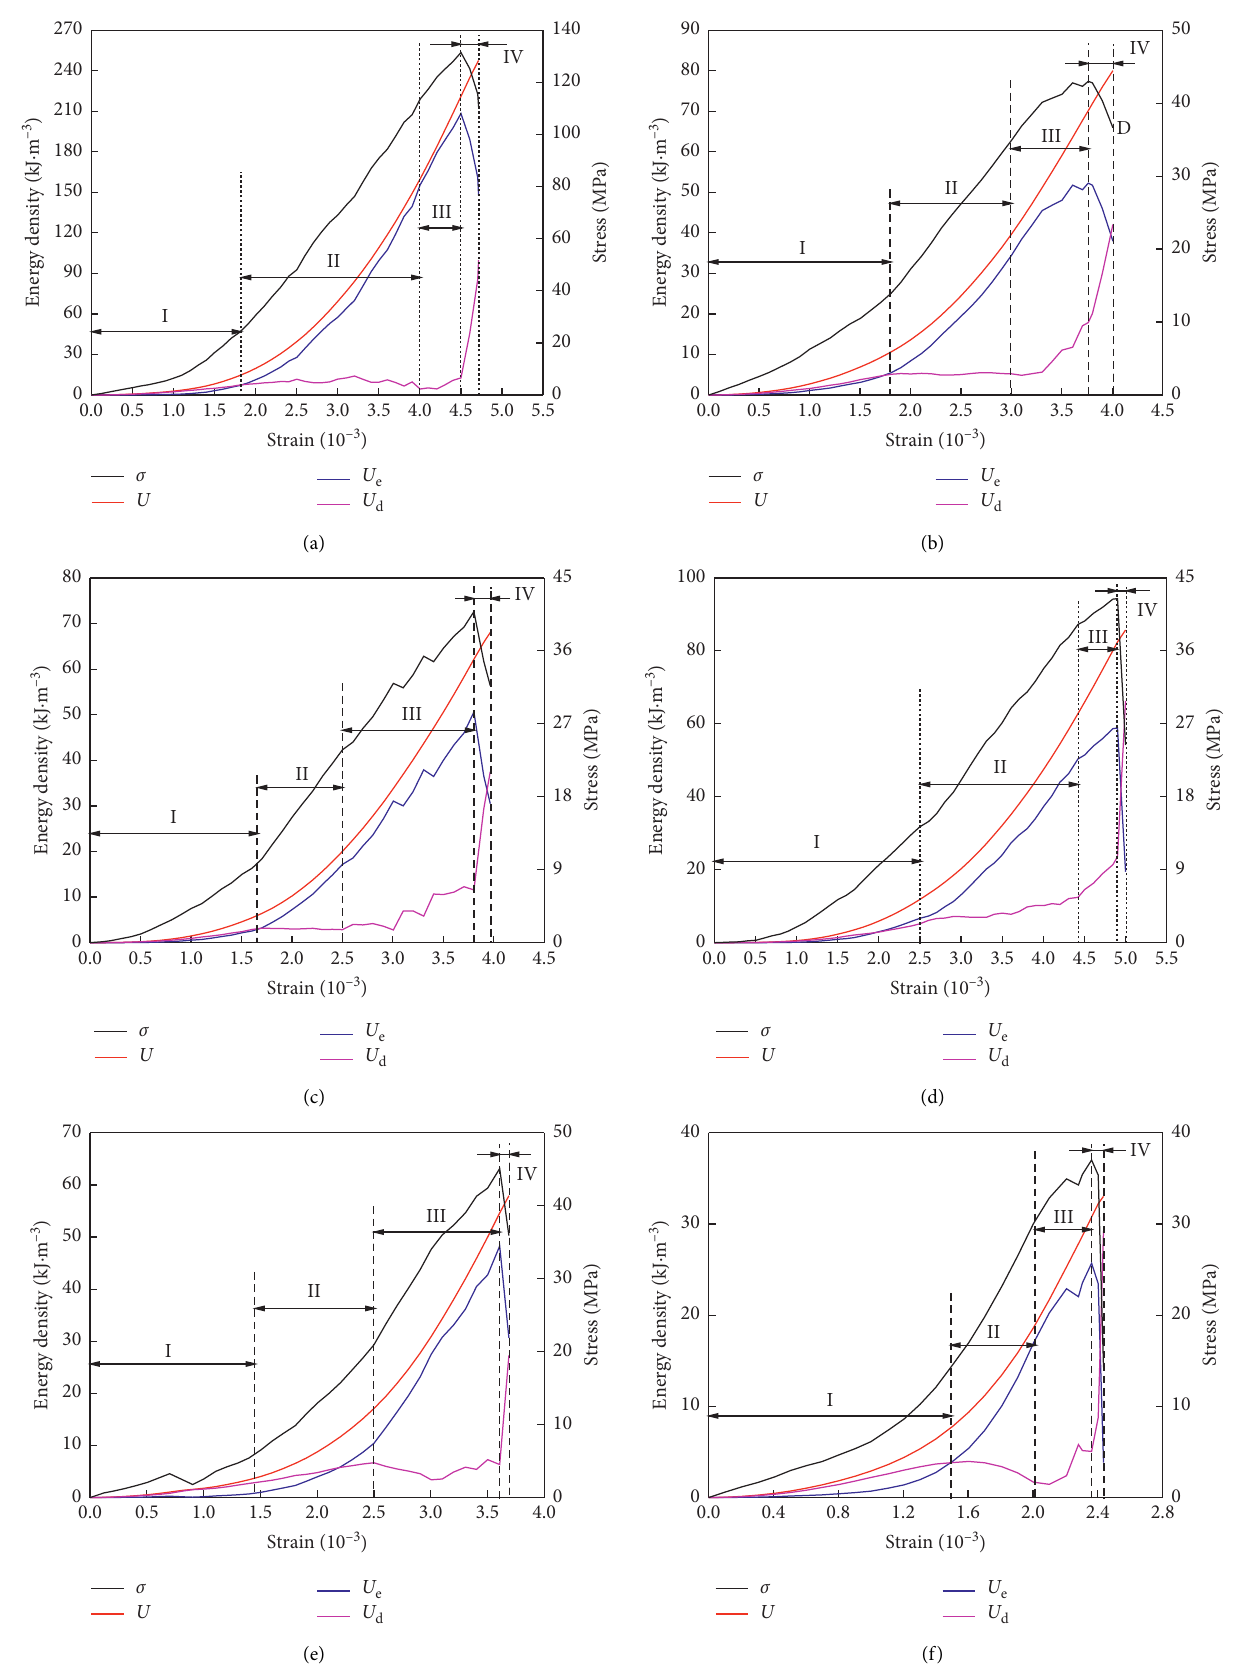
Figure 17: Energy evolution of rock specimen under UCS test. (a) Intact, (b) α � 0 ° , (c) α � 30 ° , (d) α � 45 ° , (e) α � 60 ° , and (f) α � 90 °